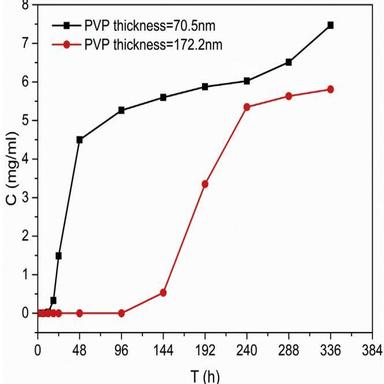
Autolytic behavior with different PVP film thickness.